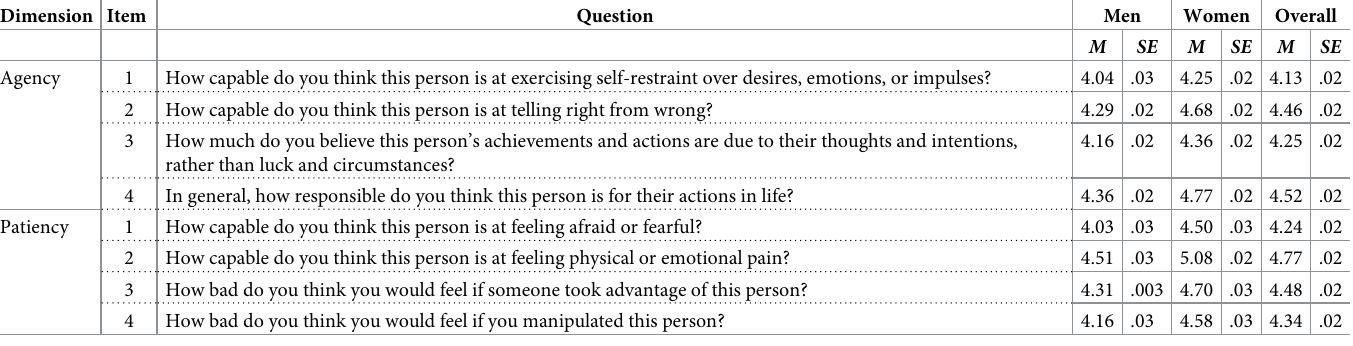
Table 3. Means ( M ) and standard errors ( SE ) of participant ratings of target women for agency and patiency items. Dimension Item